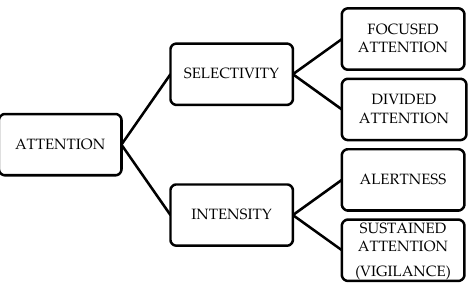
Figure 1. Supervisory attentional control (SAC), Van Zomeren and Brouwer’s Basic Process Sketch, 1994 [6], (in [7], p. 184)